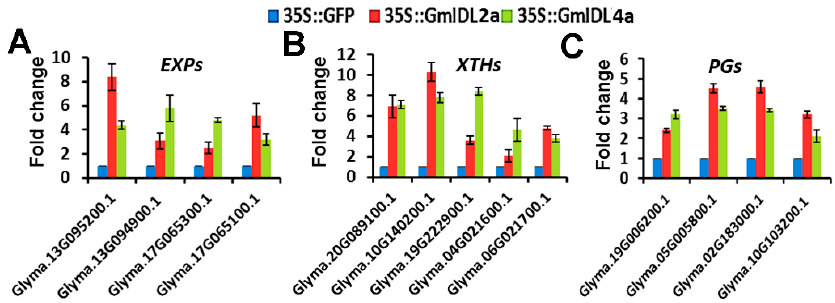
Figure 6. Expression of some members of EXPs , XTHs , and PGs genes in 35S::GmIDL2a , 35S::GmIDL4a , and 35S::GFP hairy roots. ( A ) Relative expressions of EXPs ; ( B ) relative expressions of XTHs ; and ( C ) relative expressions of PG s.